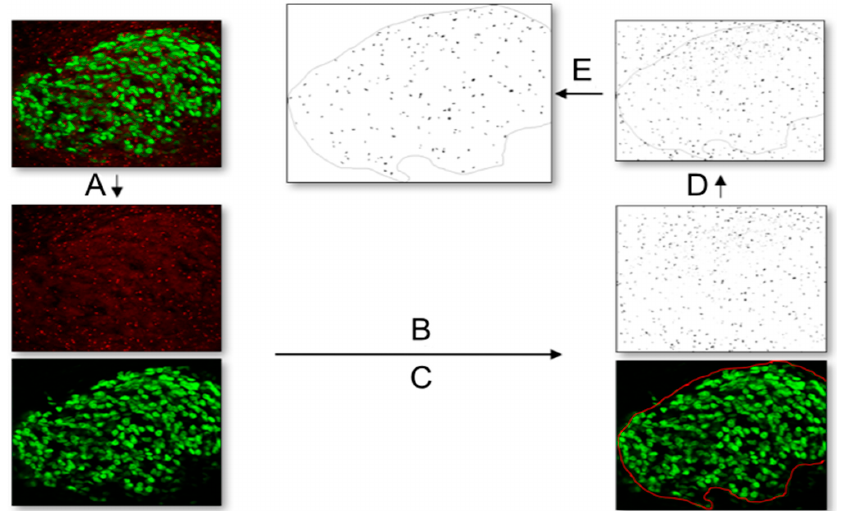
Figure 8. Workflow for quantification of primary cilia with the image analysis program Fiji. ( A ) First, a 2 ‐ channel picture with Islet ‐ 1 (green) and Arl13B (red) was split into separate channels. ( B ) On the picture displaying the primary cilia (Arl13B, red), the “triangle” threshold was applied. ( C ) The picture showing the Islet ‐ 1 ‐ positive DRG neurons was used to select the region of interest of the DRG with the freehand selection tool. ( D ) This selection was transferred to the thresholded primary cilia picture. ( E ) Finally, cilia were automatically counted within the region of interest using the “count particles” option.